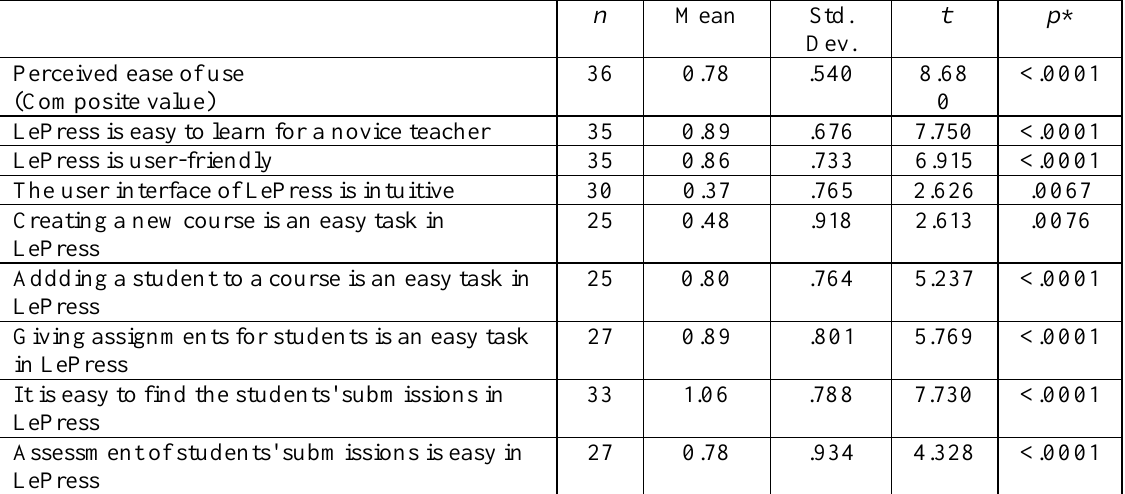
Perceived Ease of Use of LePress by Teachers